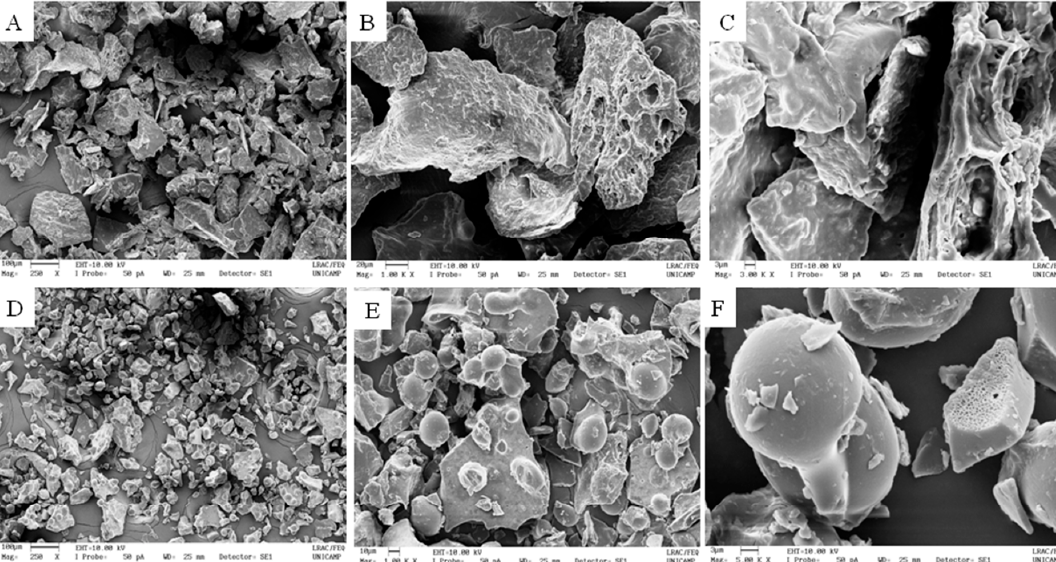
Figure 1. Scanning electron micrographs of freeze-dried blackberry pulp (BL, images A , B and C ) and freeze-dried microencapsulated blackberry pulp (ML, images D , E and F ) powders: images ( A , D ) 250 × magnification, ( B , E ) 1000 × magnification, ( C , F ) 3000 × magnification.